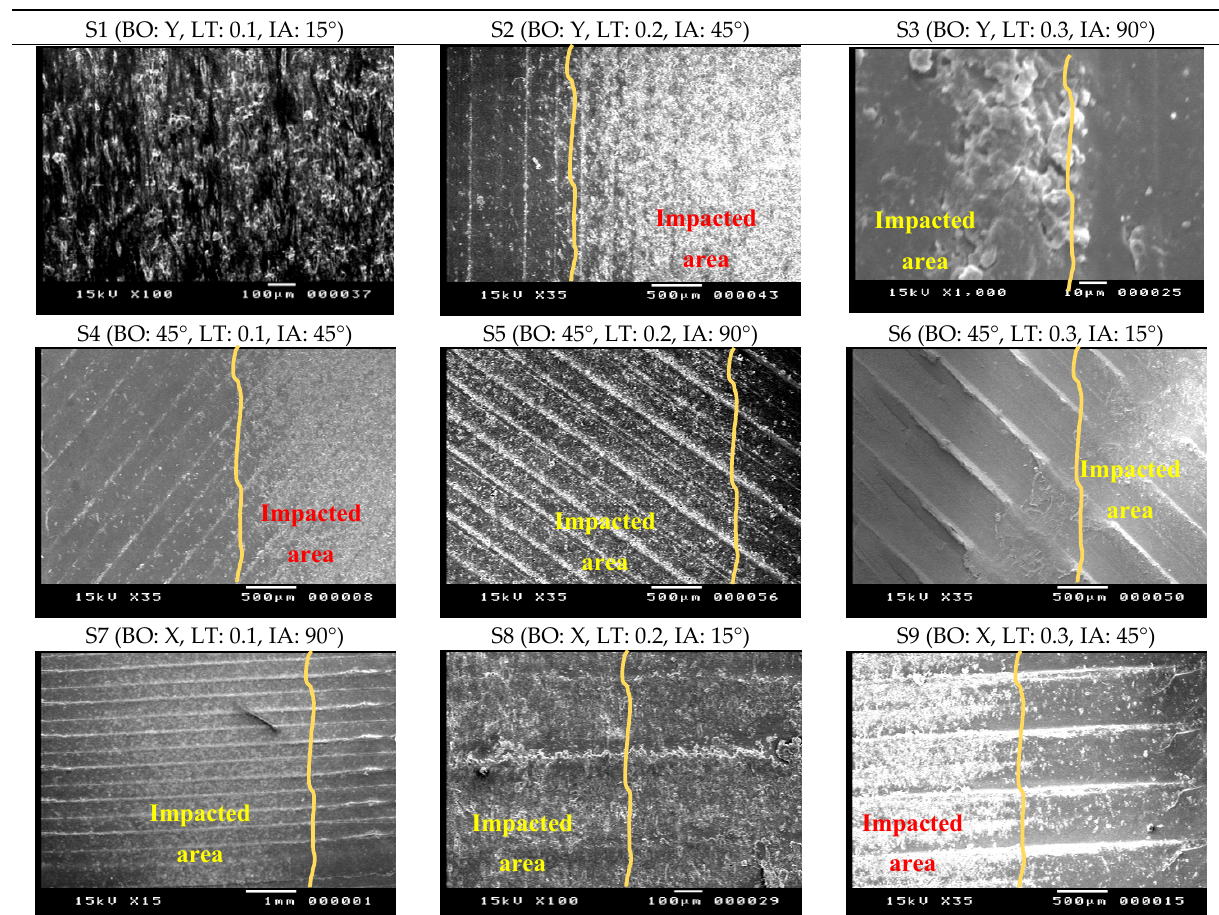
Figure 10. SEM images of the 3D printed PLA specimens after subjecting to the slurry impacts. Figure 12 shows the gain rate, Gr (mg/cm 2 ), in the weight of each specimens after impacting by 112.37 g of SiO 2 solid particles with 427.5 µ m average size. The gain rate, Gr, was determined by dividing the absolute weight gain (mg) of the specimen by the eroded surface area. The area of the eroded surface, EA, represents nearly the half of the specimen top surface area, (i.e., 5 mm × 23 mm). In addition, weights of the absorbed water due to the slurry impact tests were determined by drying the specimens after tests, and the weight of the absorbed water for each specimen was determined by determining the difference between the weights before and after the drying process, as shown in Figure 9. Finally, the difference between the total gain weight and the weight of the absorbed water for each specimen was determined to represent the net gain weight of the specimen after the slurry impact test. The net gain weight is due to the penetrations and immersions of the solid particles accompanied with the mass loss which may be occurred due to the successive slurry impacts, as shown in Figure